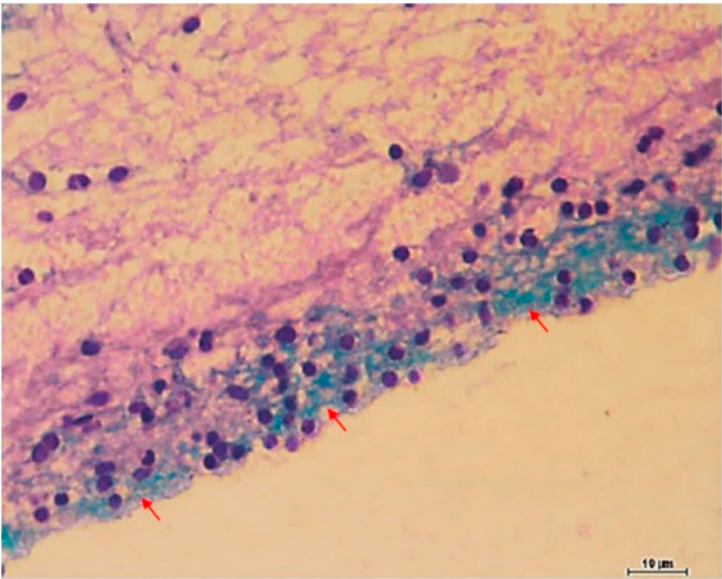
Figure 3. Representative image of exopolysaccharide (EPS) matrix on meninges of the tilapia model. Piscine GBS on the meningeal surface secretes acidic polysaccharides—light blue (red arrows). Neu- tral mucopolysaccharides of the brain parenchyma—magenta. Nucleus—dark blue. Myelencephalon, AB/PAS stain. For interpretation of the references to color in this figure legend, the reader is referred to the web version of this article. https://doi.org/10.1016/j.micpath.2016.10.029, accessed on 7 November 2022. Reprinted from [25], Copyright (2017), with permission from Elsevier.